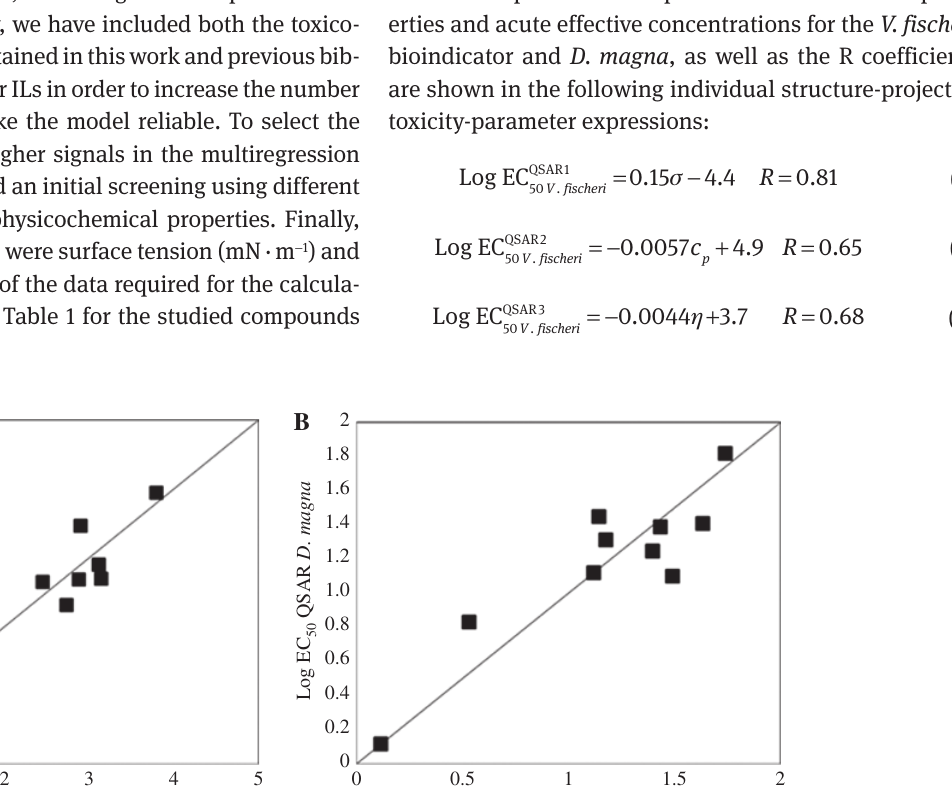
Figure 5: Plots of predicted vs. experimental values of log EC Daphnia magna (B).